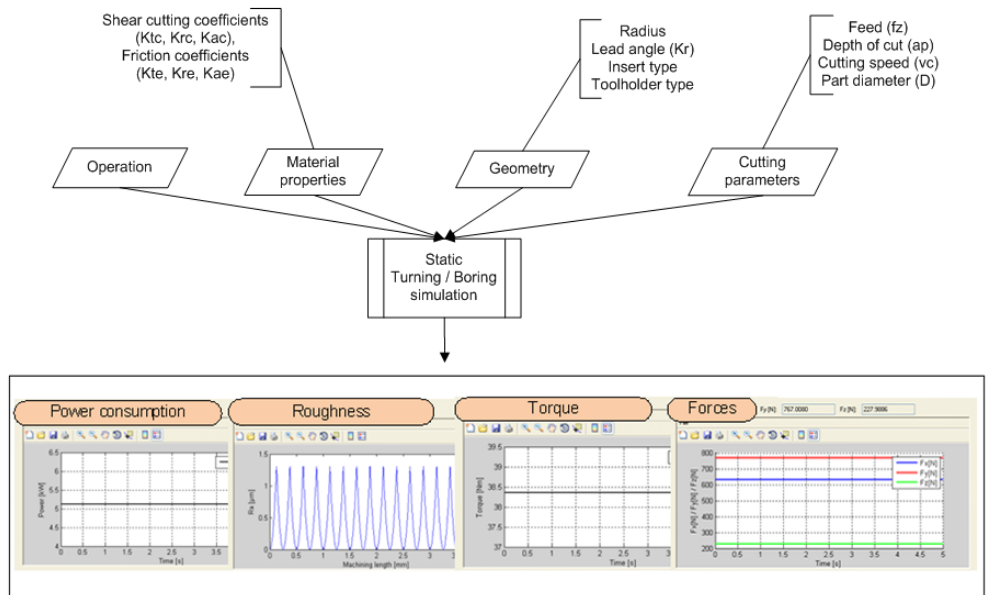
Figure 3. Model dataflow in a static-state condition.